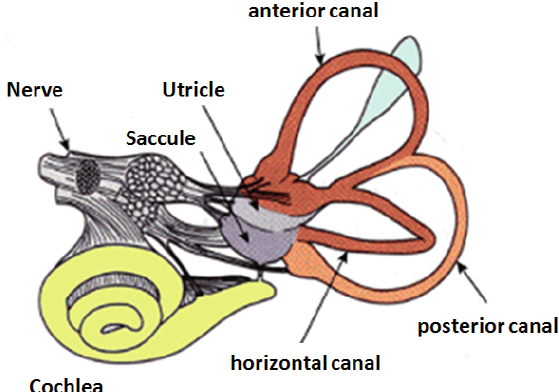
Figure 1. Illustration of the human vestibular system and its components